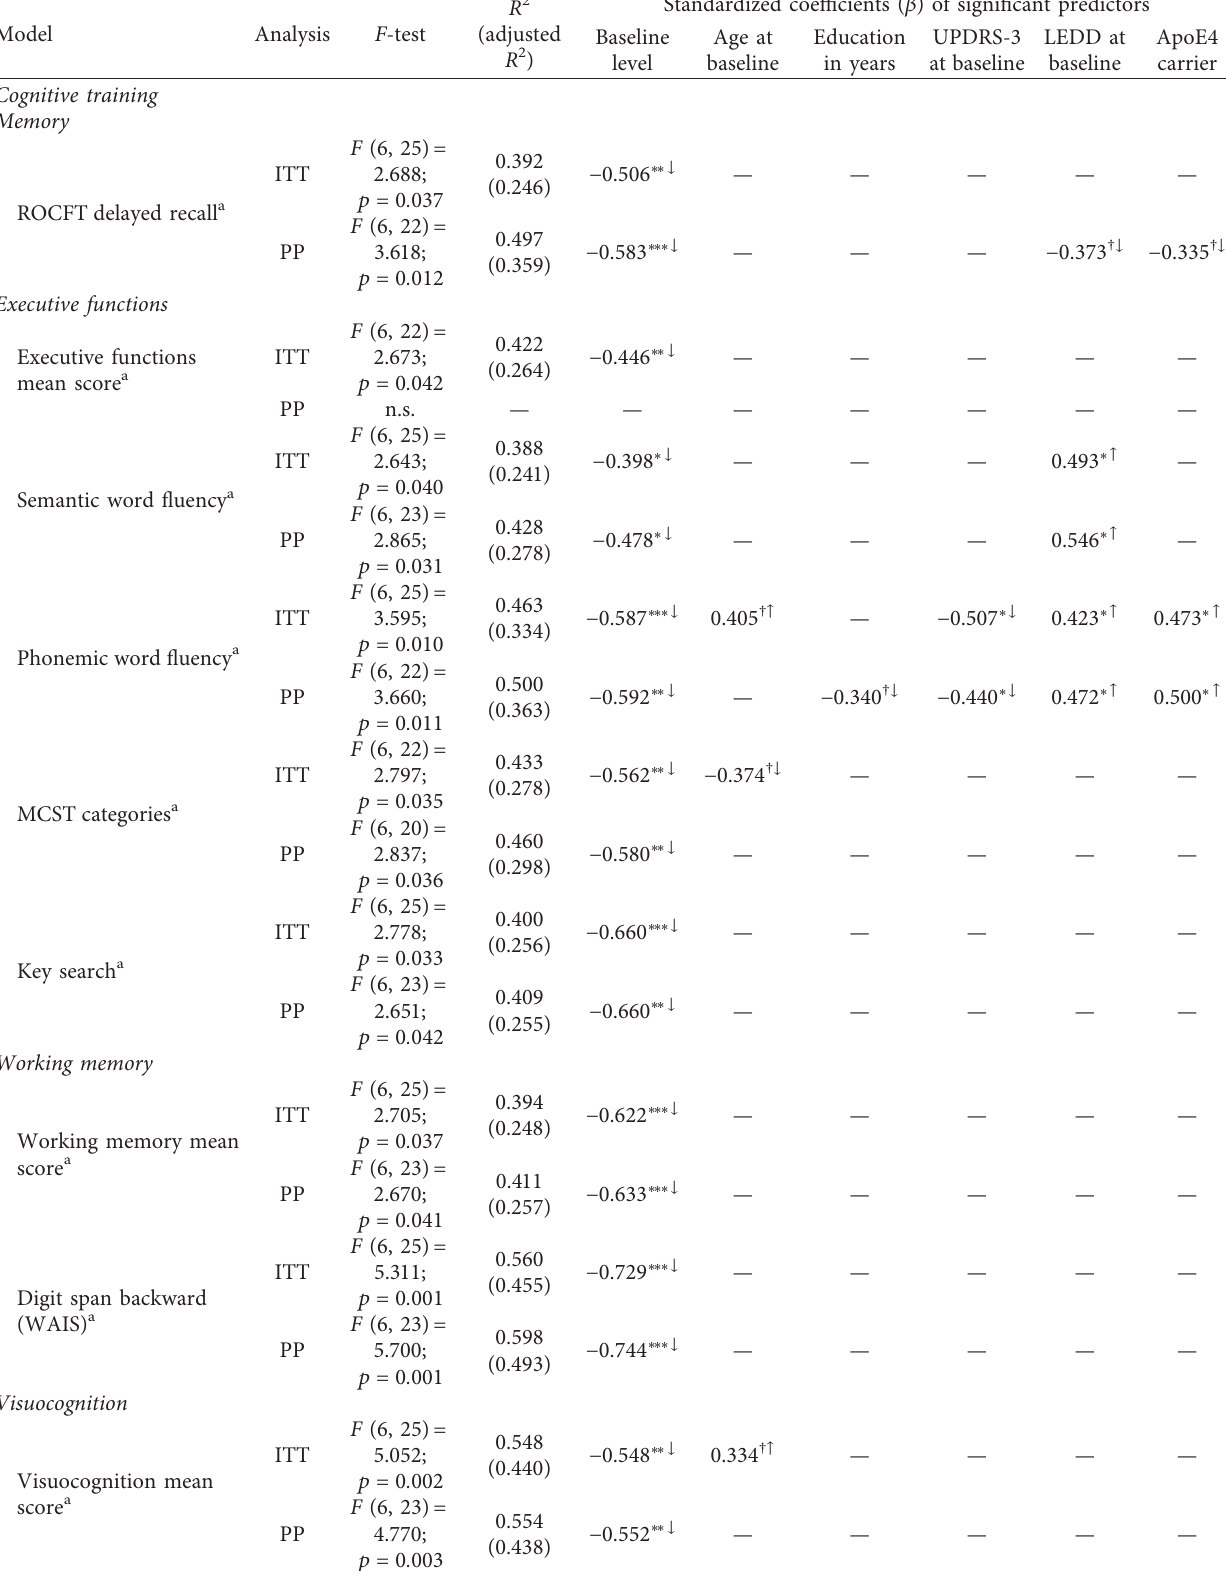
Table 4: Regression analyses: predictors for intervention